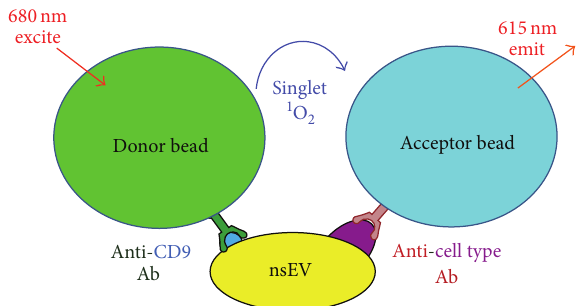
Figure 2: ExoScreen nsEV quantification assay schematic. Upon excitation at 680nm the phthalocyanine-loaded donor bead con- verts endogenous diatomic oxygen to singlet oxygen. When donor beads are adequately proximal ( ∼ 200 nm) to thioxene-loaded accep- tor beads donor bead singlet oxygen causes emission of a 615nm photon from the acceptor beads and produces a luminescent signal detected by the ExoScreen plate reader. For quantification of nsEVs derived from a particular tissue type donor bead exteriors are covalently coupled with anti-CD9 (nsEV surface marker protein) Abs and anti-cell type surface marker protein Abs are coupled to acceptor beads. ExoScreen assays can be carried out in 384-well plates and thus enable parallel quantification of nsEVs derived from multiple cell types in multiple plasma samples. Figure adapted from Yoshioka et al. [19] to illustrate use of ExoScreen nsEV assay for quantification of tissue-specific, for example, neuronal,